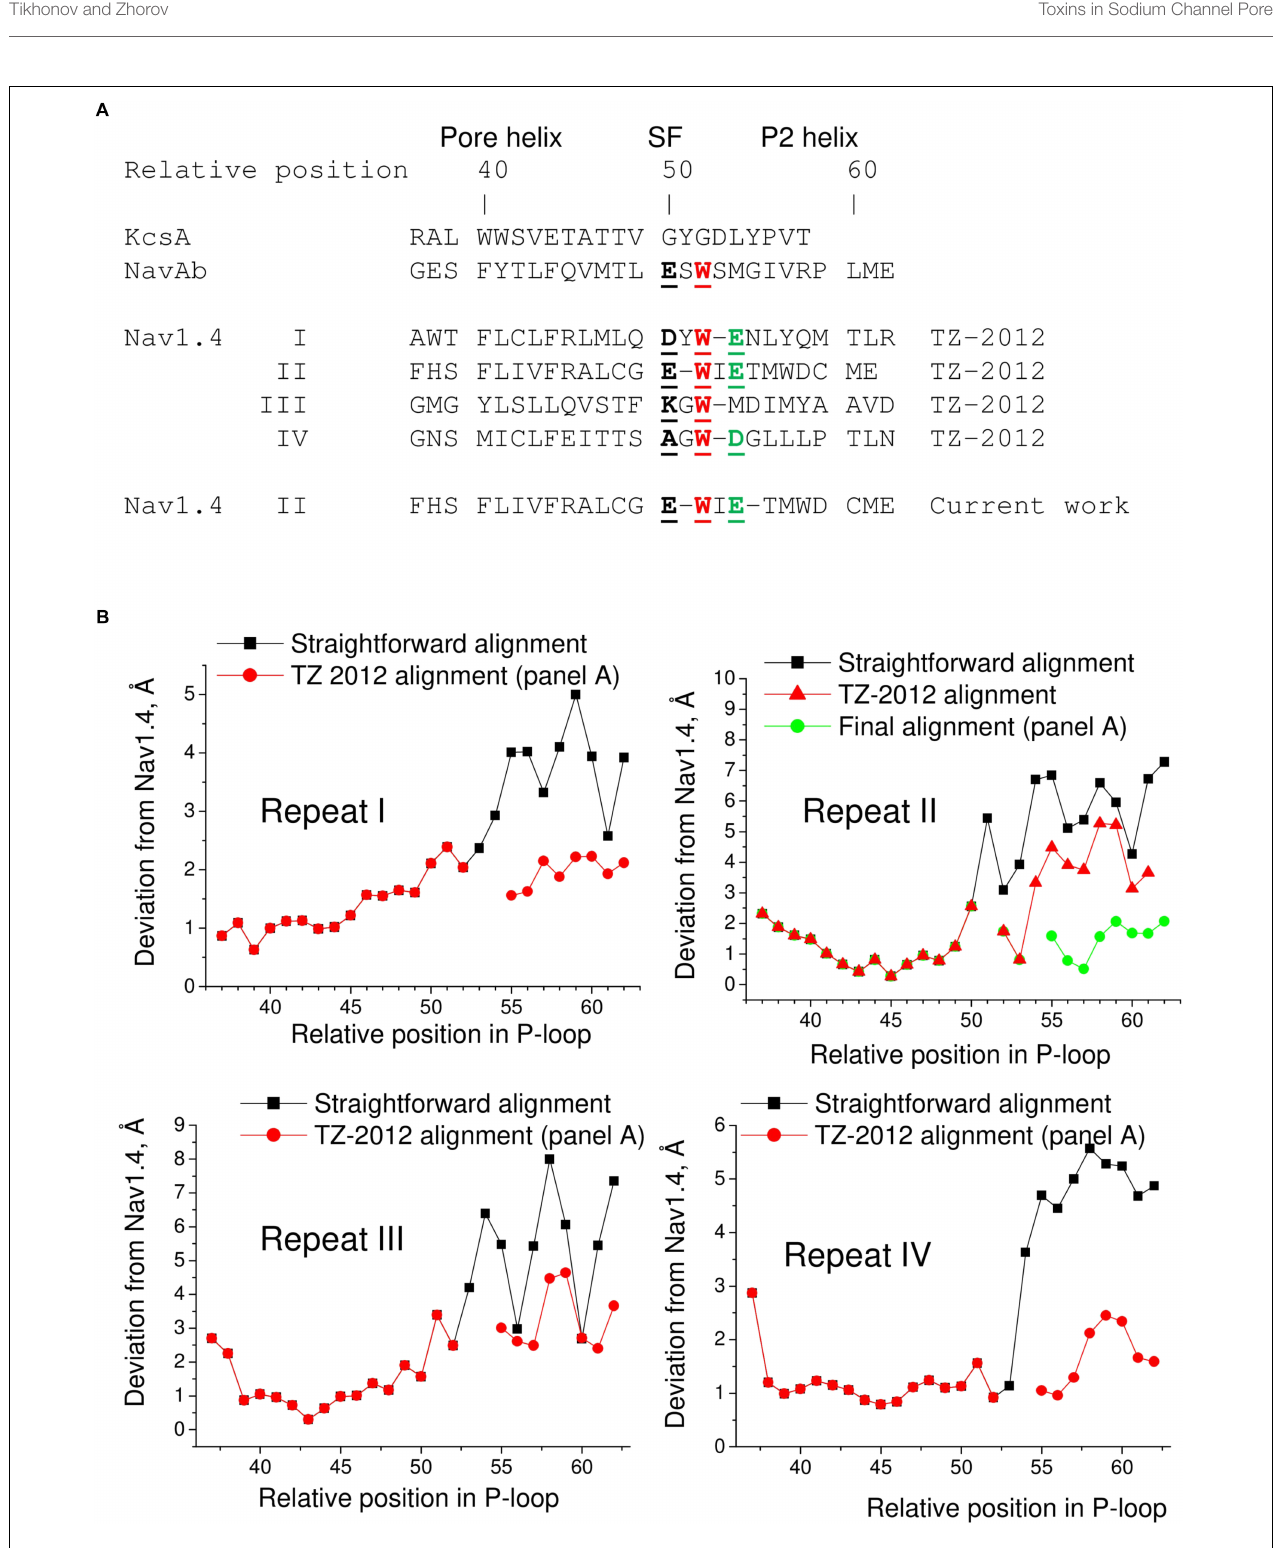
FIGURE 6 | Adjusted sequence alignment decreases deviations of matching atoms in 3D aligned structure of NavAb. (A) Adjusted sequence alignment (TZ-2012) of P-loops in KcsA, NavAb, and Nav1.4 (Tikhonov and Zhorov, 2012). Highlighted are residues in the DEKA locus, conserved tryptophans that stabilize folding of the P-loops, and the outer carboxylates. In the adjusted, but not the straightforward ( Figure 5A ) sequence alignment the conserved tryptophans are in the matching positions. The second deletion in repeat II of Nav1.4 is introduced in the current work to minimize deviations between matching alpha carbons in the P2 helices of NavAb and Nav1.4. (B) Deviation of alpha carbons in repeats I-IV of Nav1.4 from the NavAb atoms, which are considered as matching according different sequence alignments. Introducing deletions decreases deviations and smoothes the deviation curves.